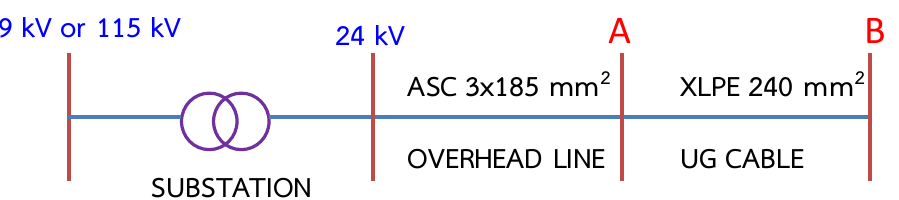
Figure 24. The 24 kV distribution line system.